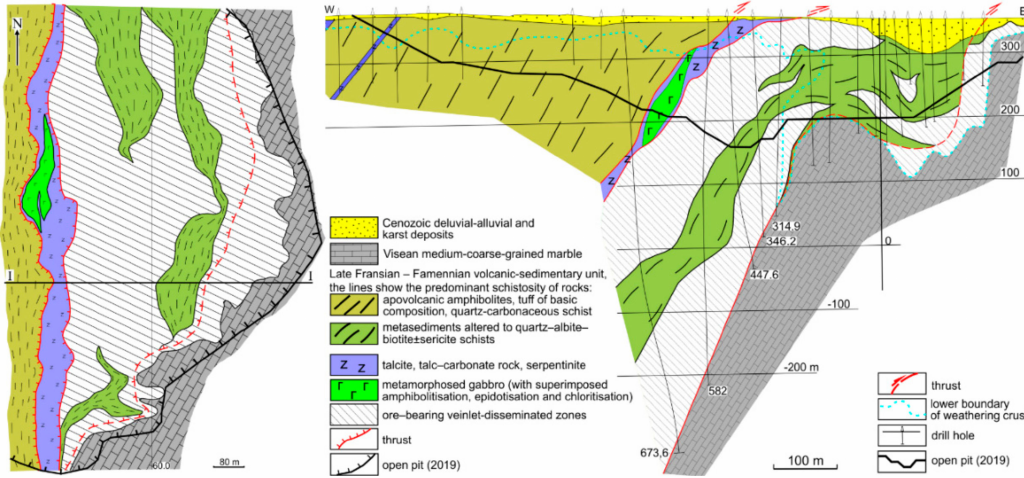
Figure 3. Schematic geological map of the Svetlinsk gold deposit, based on the Kochkar geological team data [25], and cross-section I-I, modified after